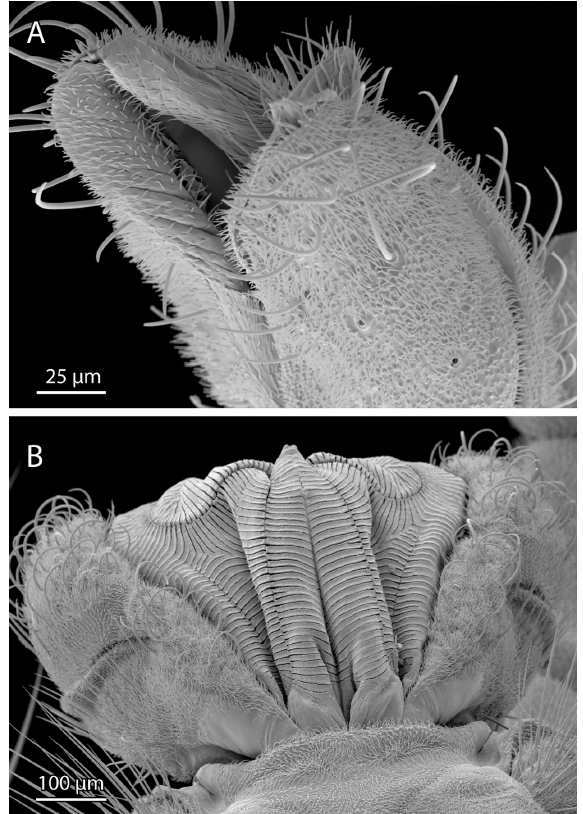
Figure 6 . Head capsule, SEM images. A, Chaoborus christallinus (Chaoboridae), lateral. B, Corethrella appendiculata (Corethrellidae), frontal. Abbreviations: a, antenna; lbr, labrum; md,